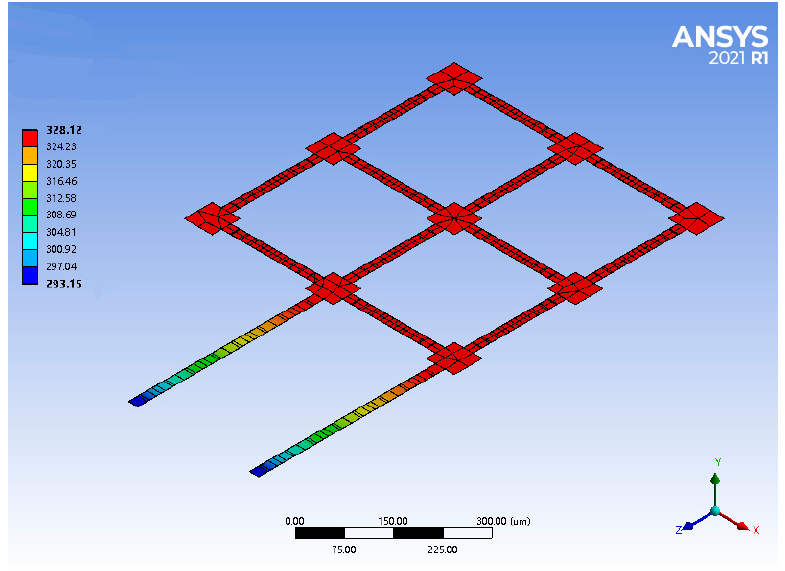
Figure 2. FEA results of temperature distribution across the bilayer solar sail by applying a voltage of 0.04 V.